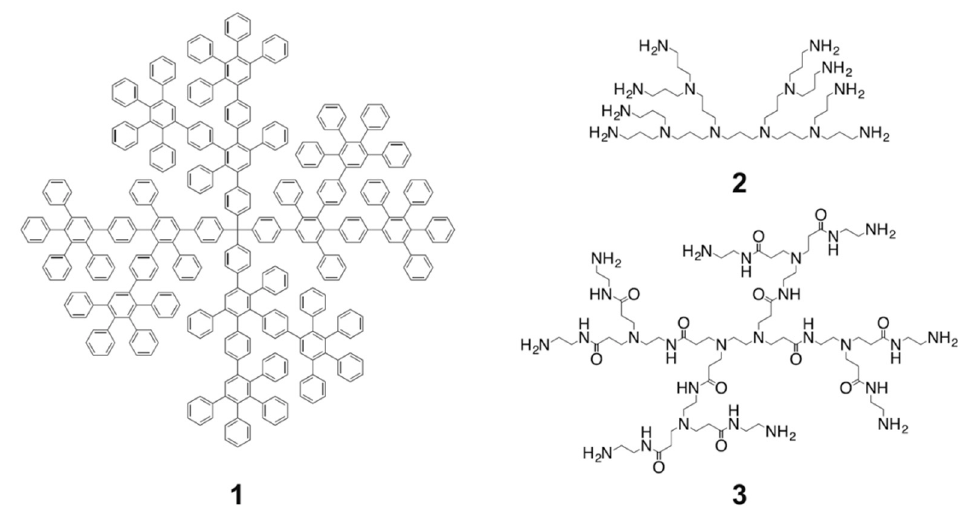
Figure 45. A structural comparison of ( 1 ) a rigid, shape-persistent (G1); poly(phenylene) dendrimer (PPD) to ( 2 ) flexible (G1); poly(propylenimine) (PPI) dendrimers and ( 3 ) flexible (G1); poly(amidoamine) (PAMAM) dendrimer [191].